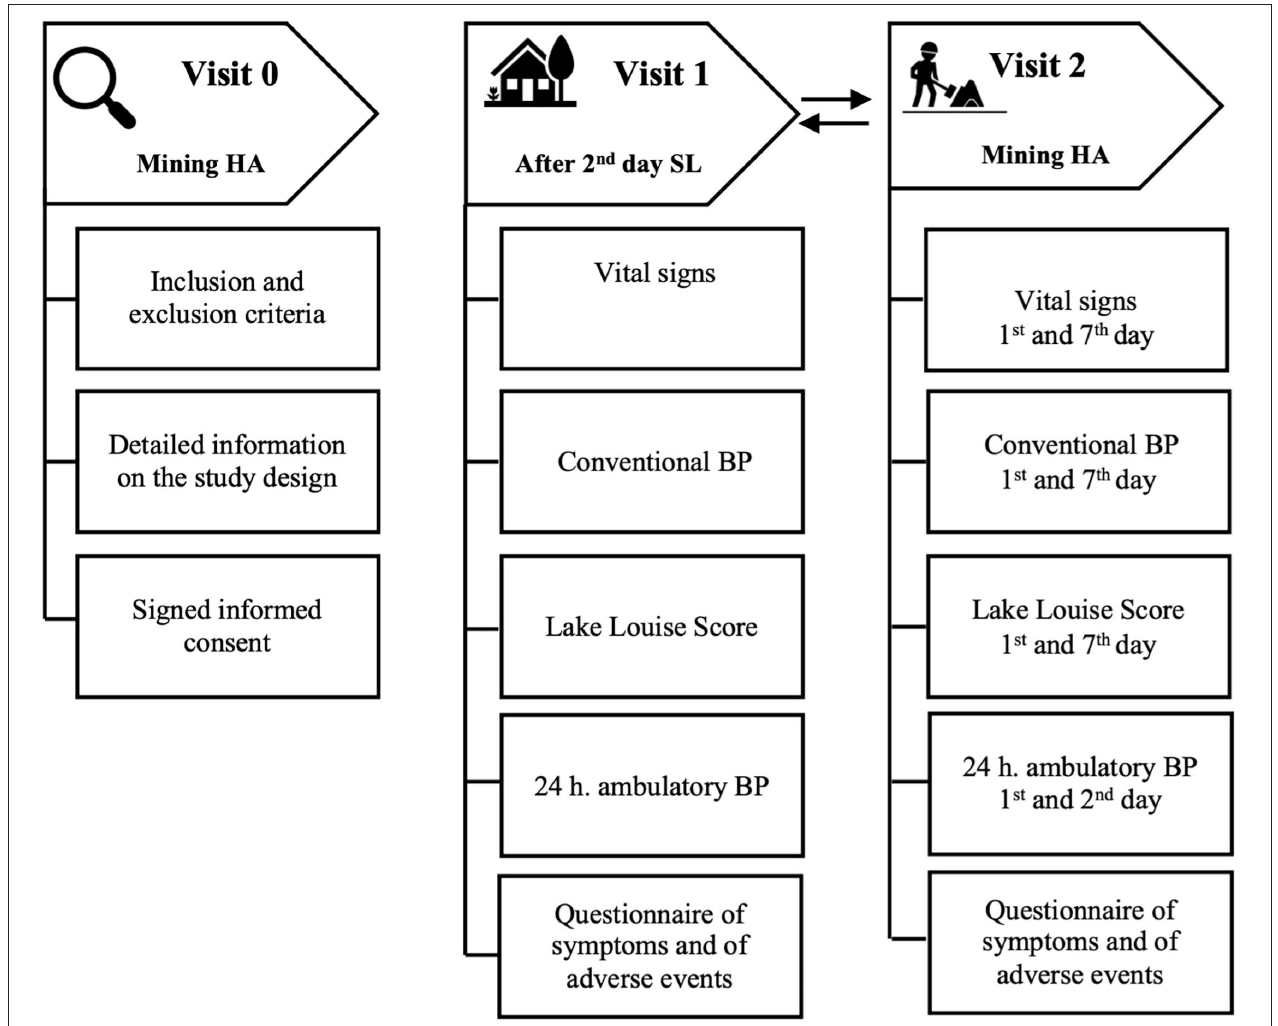
FIGURE 1 | Study design and